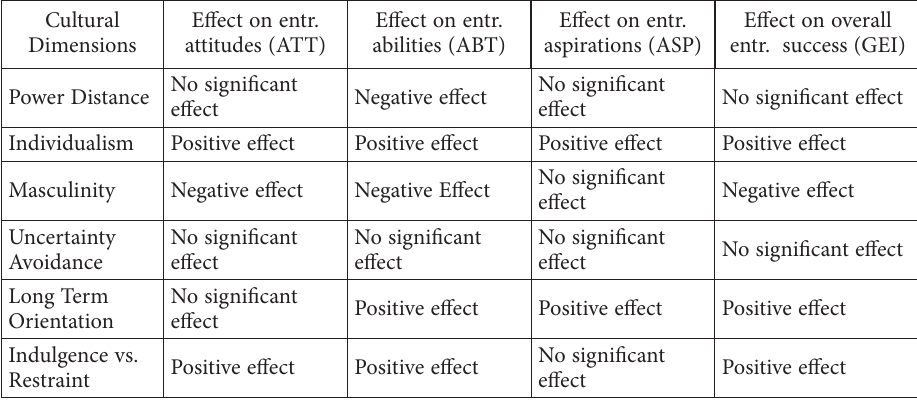
Table 1. Effects of cultural dimensions on entrepreneurship, summary Cultural Dimensions